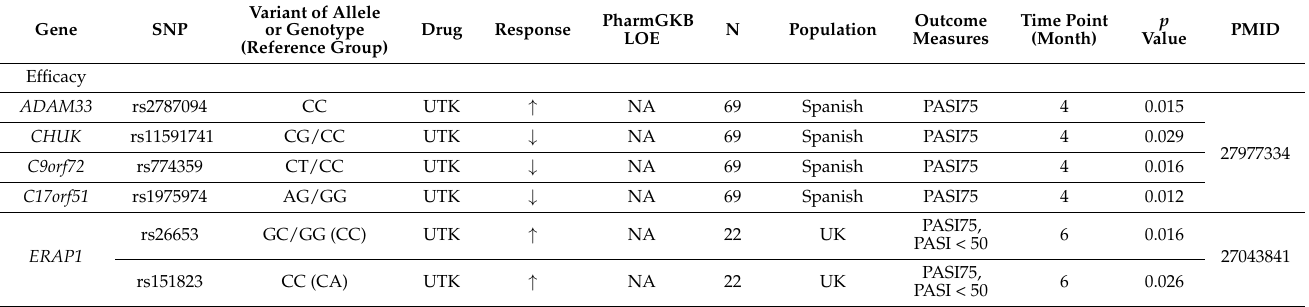
Table 5. Genetic polymorphisms associated with response of IL-12/IL-23 antagonist in patients with